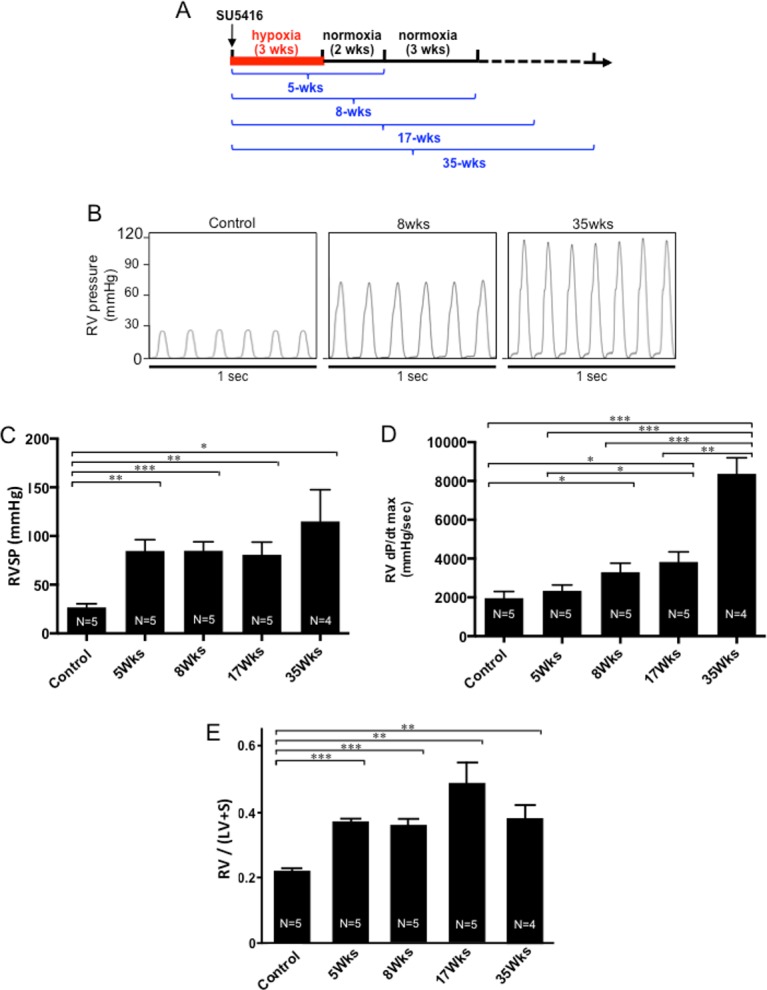
RV hemodynamics.SU5416-injected rats were subjected to 3 weeks in hypoxia and then maintained in normoxia for 2, 5, 14 or 32 weeks (5-, 8-, 17- and 35-wks time points, respectively). Animals were anaesthetized, ventilated and the chest opened. A Millar catheter was inserted into the RV apex and hemodynamic measurements were performed. (A) Flow diagram of the experiments. (B) Representative hemodynamic traces. (C) Means ± SEM of RVSP. (D) Means ± SEM of dP/dtmax. (E) Means ± SEM of the ratio of RV weight to LV + septum weight. *Significantly different from each other at P < 0.05. **Significantly different from each other at P < 0.01. ***Significantly different from each other at P < 0.001.